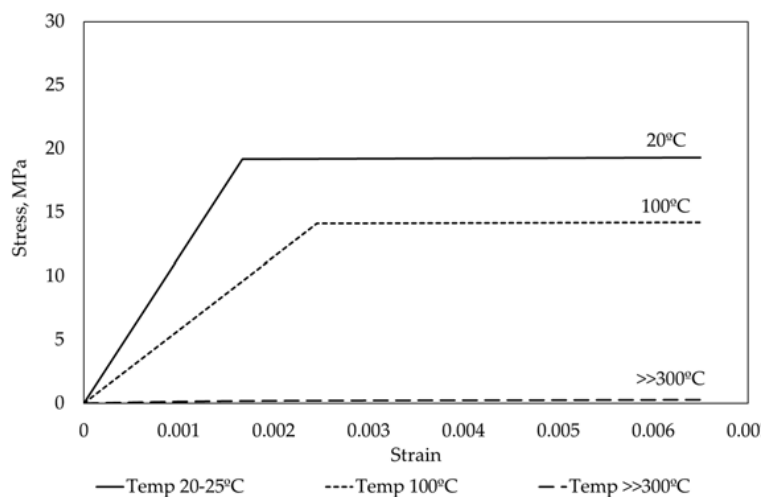
Figure 3. Strain–stress of GL20H wood at different temperatures.